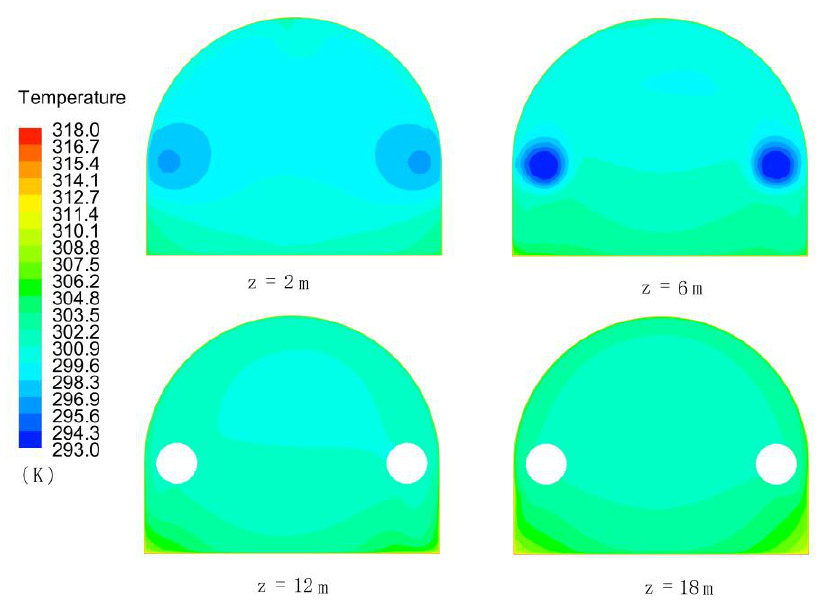
Figure 16. Model 5 section temperature distribution.